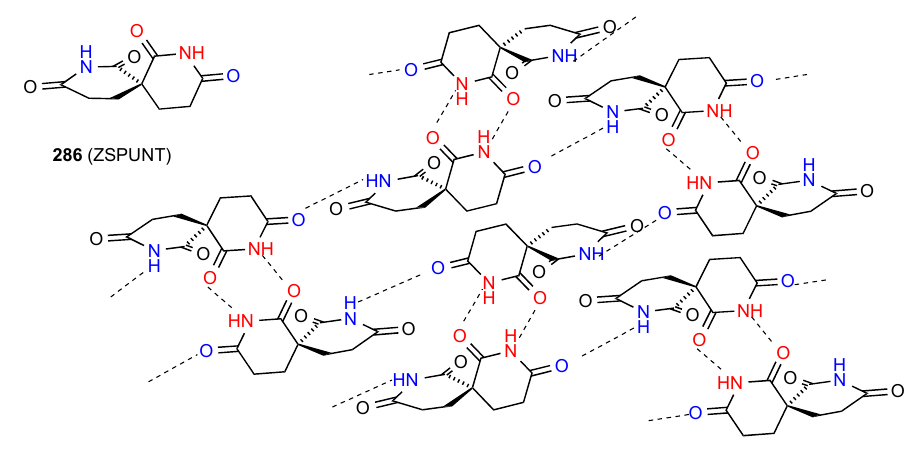
Figure 83. Structure adopted by compound 286.